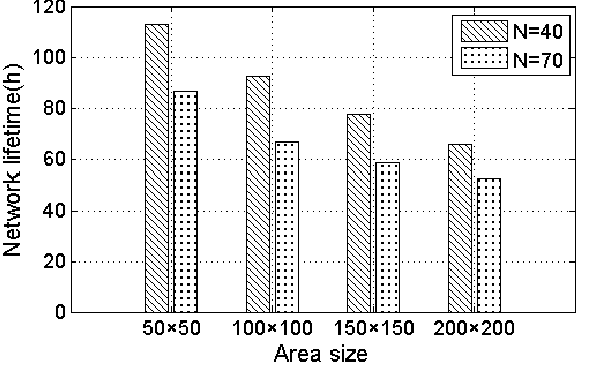
Figure 5. The effect of different area sizes on the network lifetime.